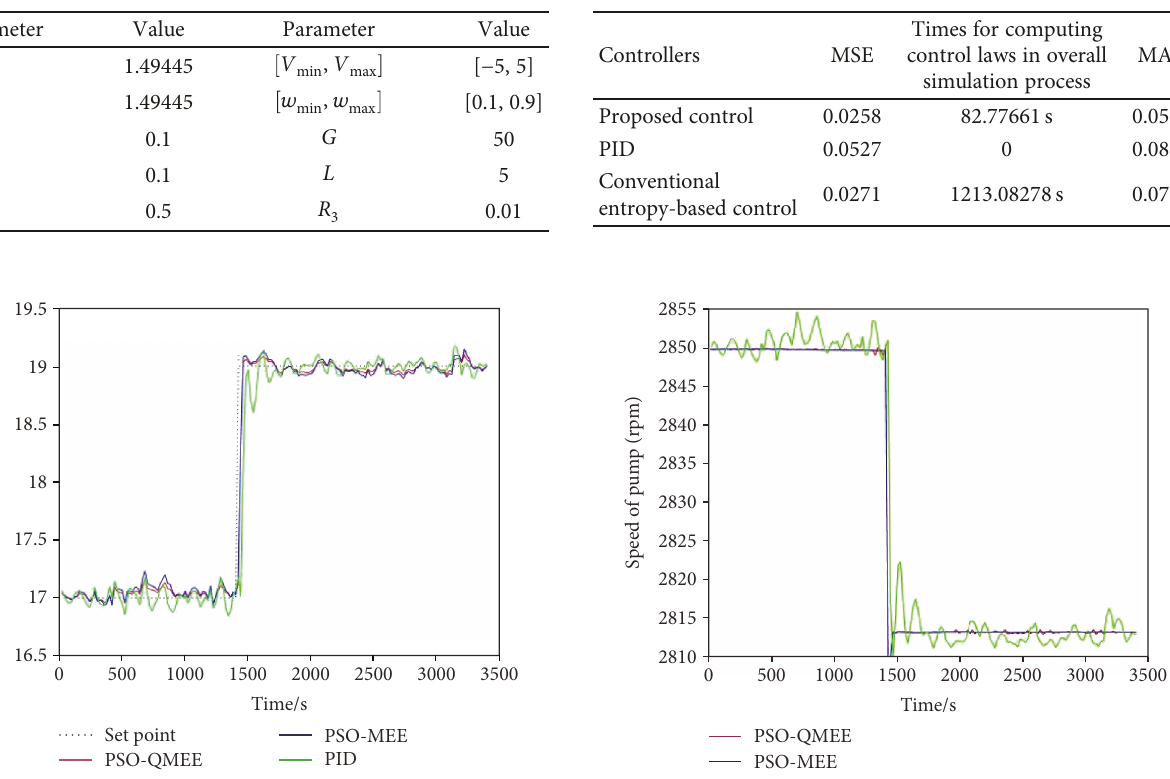
and v . k k Table 2: Comparative results using three controllers.